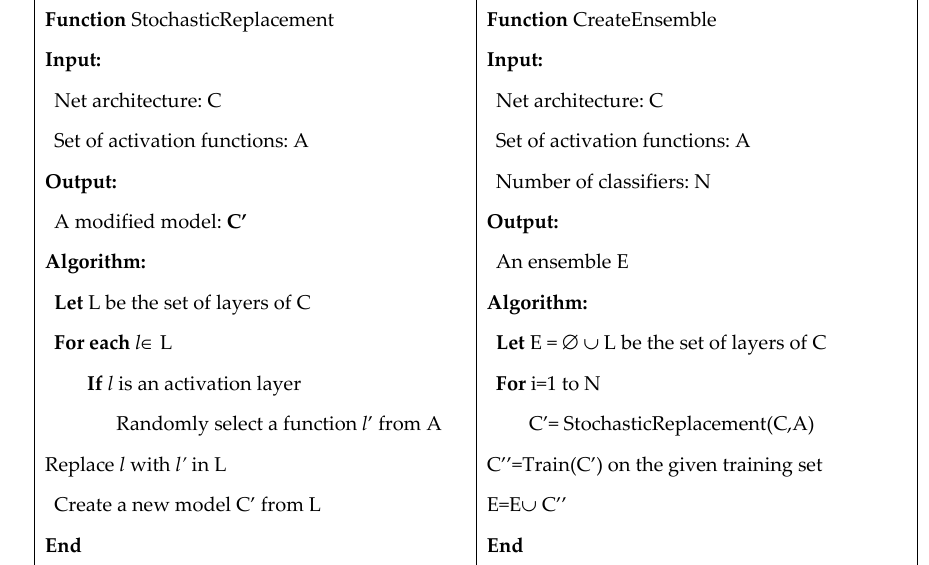
Table 3. Summary of the Medical Datasets for image classification: short same (ShortN), name, number of classes (#C), number of samples (#S), image size, testing protocol, and reference.